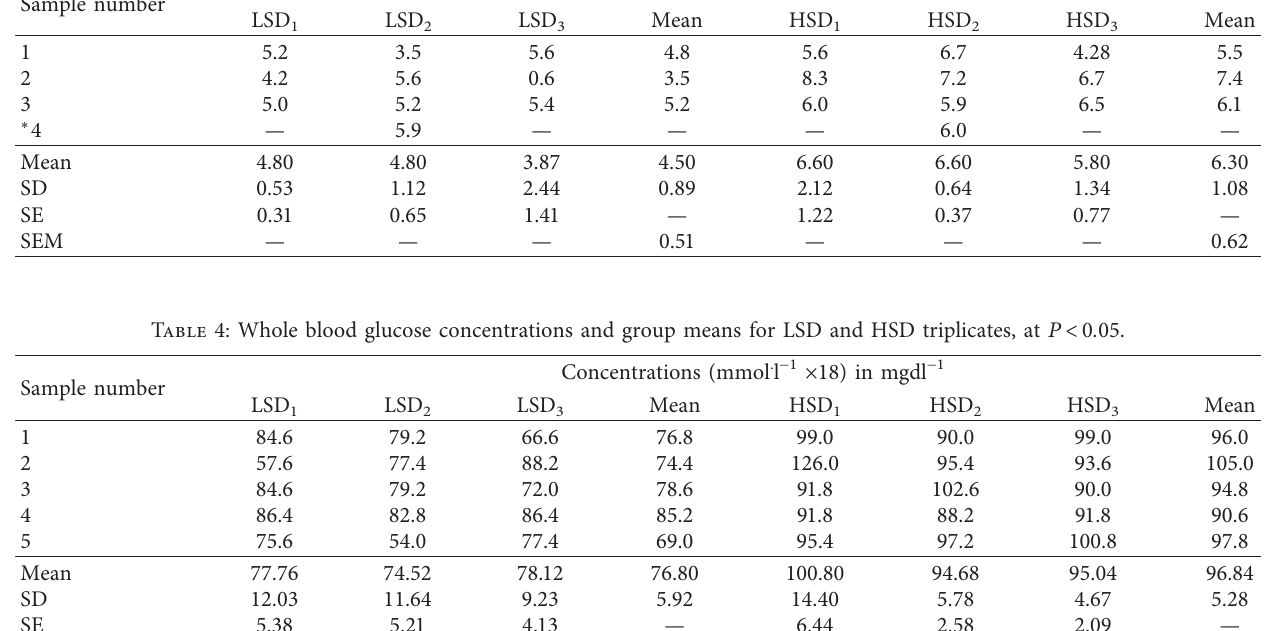
Table 3: Cortisol concentrations and group means for LSD and HSD triplicates, at P < 0 . 05. Sample